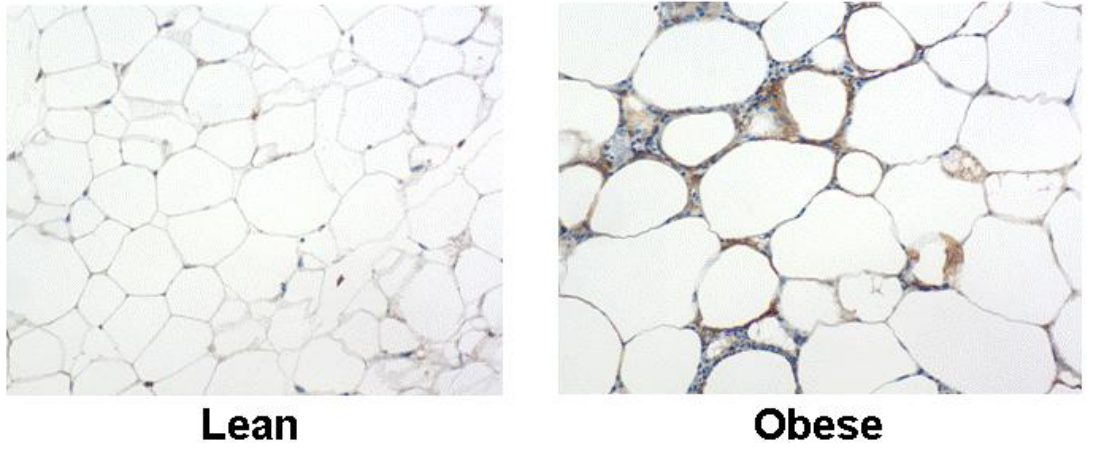
FIGURE 1. Representative photomicrographs of adipose tissue sections from lean and obese mice immunostained with the macrophage specific marker F4/80. Adipose tissue from obese mice shows a remarkable infiltration of macrophages that form ―crown- like‖ structures that surround necrotic adipocytes and scavenging adipocyte